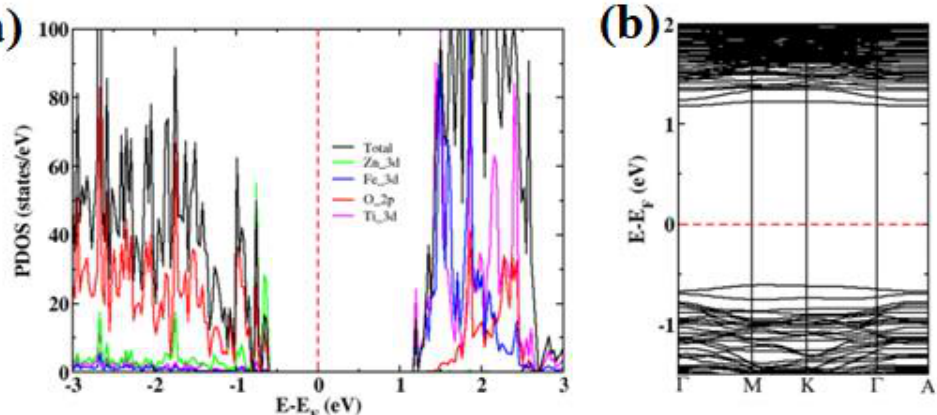
Figure 4. PDOS ( a ) and band structure of (Zn, 2Ti)-codoped {0001} α-Fe 2 O 3 surface ( a , b ). The Fermi level is set to zero.